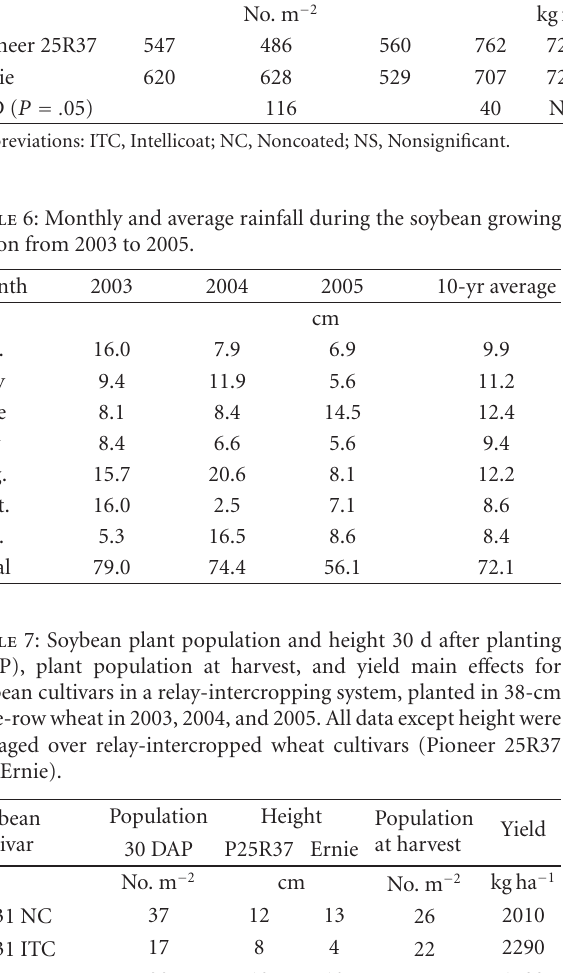
Table 5: Wheat cultivar shoot density, test weight, moisture, and soybean yield main e ff ects for cultivar in a relay-intercropping system planted in 38-cm wide rows in 2003, 2004, and 2005. All data except shoot density were averaged over relay-intercropped soybean cultivars (H431 NC, H432 ITC, and DK 38–52). Wheat shoot density Wheat test weight Wheat moisture Wheat yield Wheat cultivar